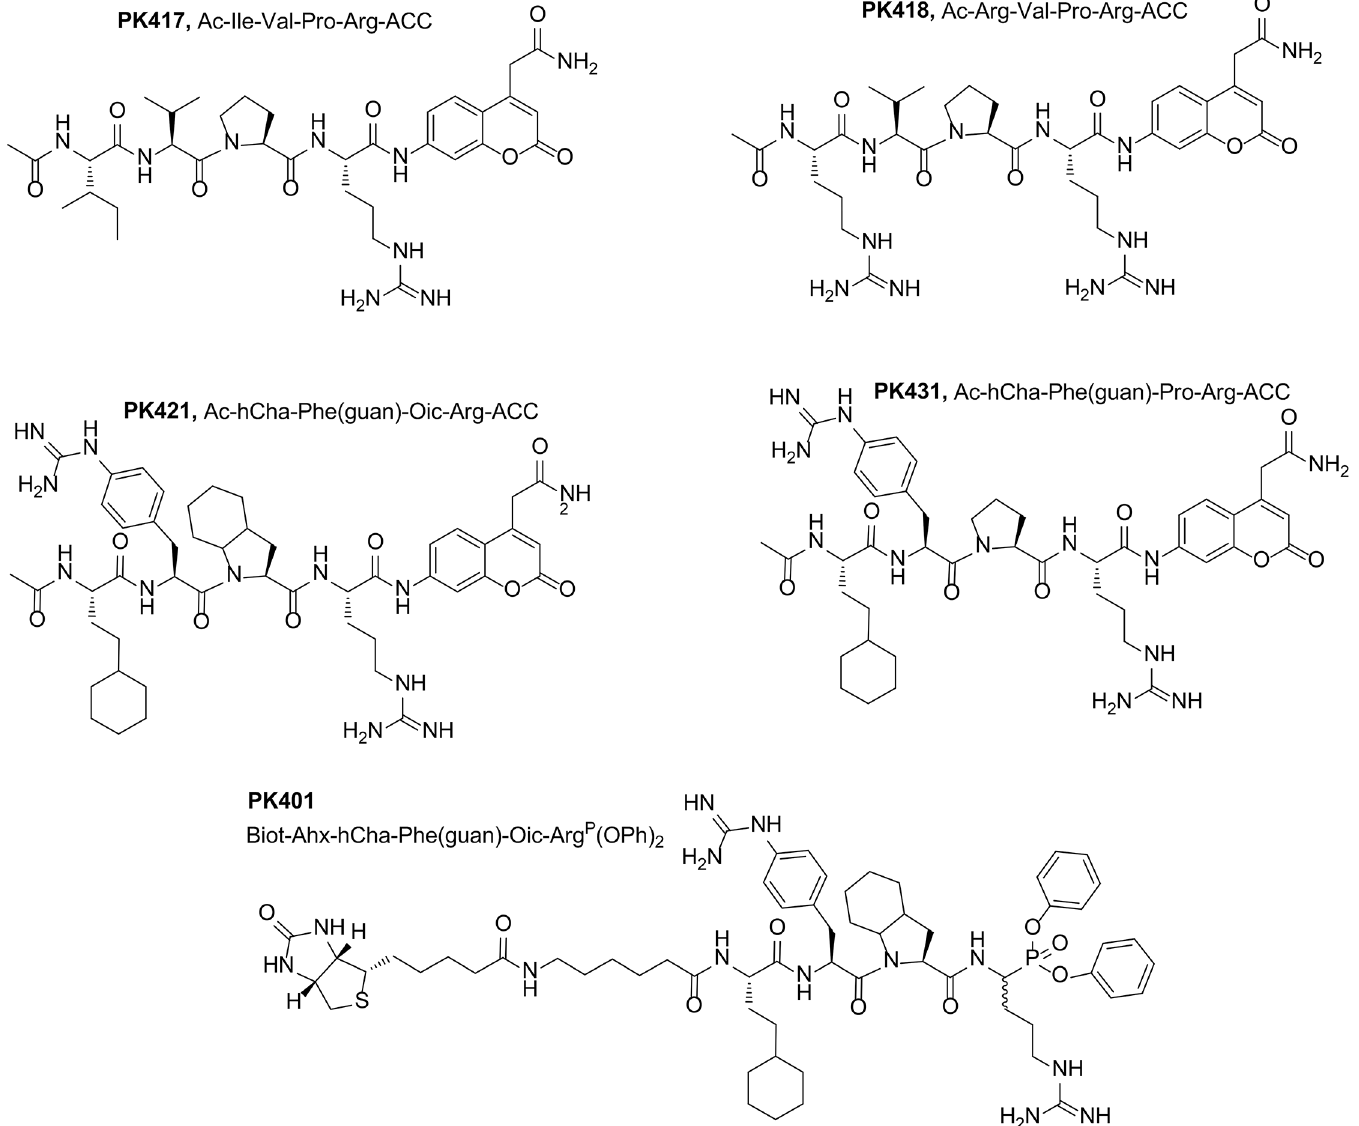
Fig 3. Structures of the optimized NSP4 substrates based on natural (PK417 and PK418) and natural/unnatural amino acids (PK421 and PK431). The activity-based probe (PK401), a diphenyl phosphonate derived from the optimal substrate sequence — PK421 — is shown as the last structure.